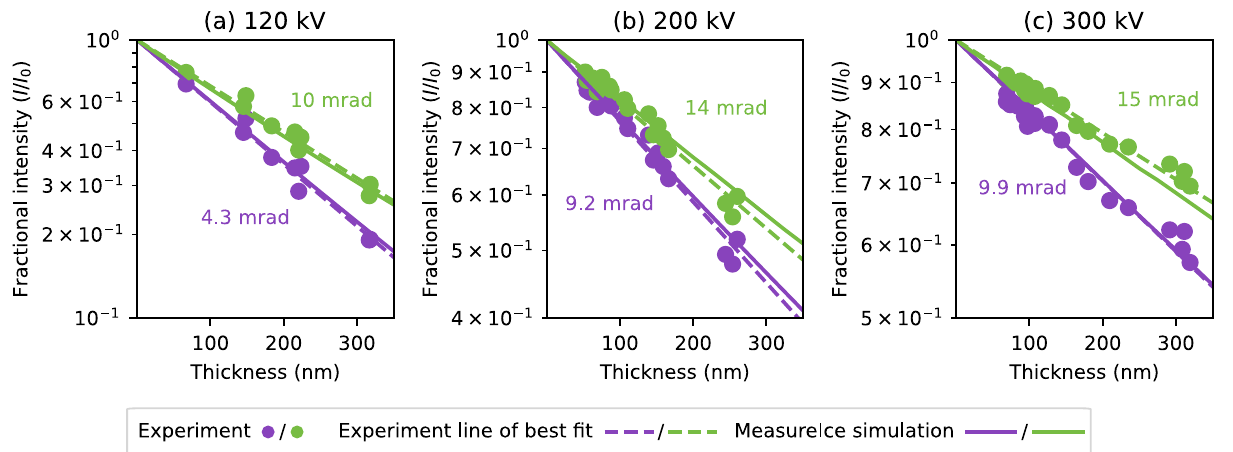
Fig. 2 Simulated Ice thickness — image intensity maps (MeasureIce simulation) for three different microscope accelerating voltages. Displayed are a 120 kV, b 200 kV, and c 300 kV and different objective apertures with benchmarking using the ice channel method (Experiment) along with the line of best fi t. The Pearson correlation coef fi cients ( r 2 ) indicate the quality of agreement between experimental datapoints and the MeasureIce simulation (not the experiment line of best fi